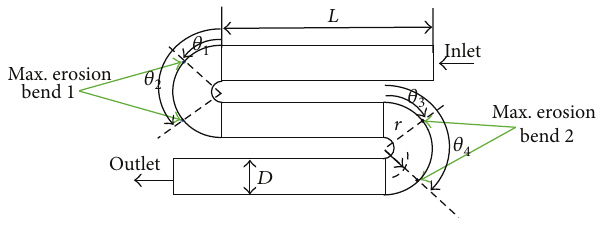
Figure 1: S-bend geometry with 𝑟/𝐷 = 1.5 .